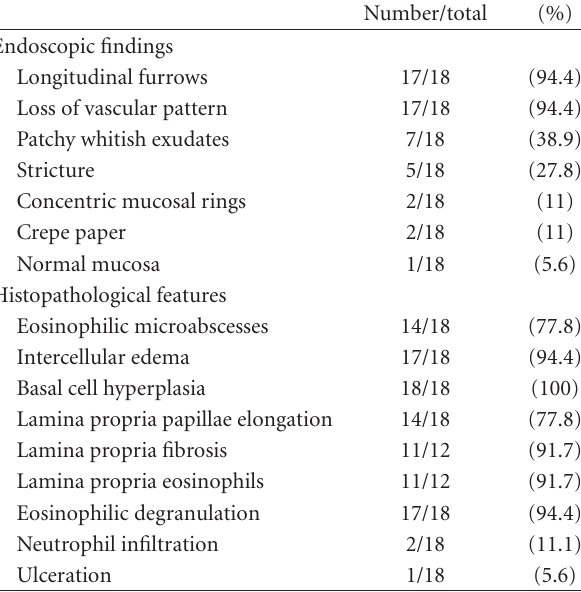
Table 1: Clinical and laboratory characteristics of children with eosinophilic esophagitis ( n = 18).